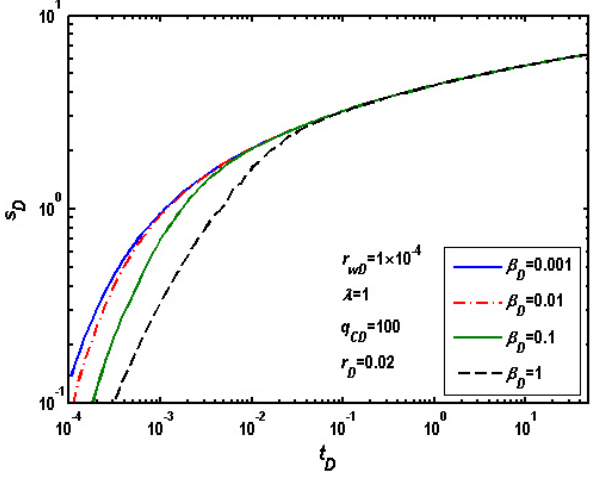
Figure 8. Time-drawdown at r D = 0 . 02 for different inertial force coefficients in a log–log